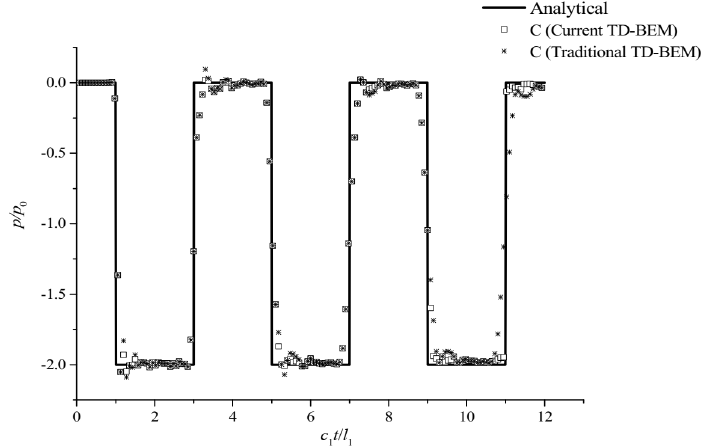
Figure 9. Comparison between the results of traction from current 3D TD-BEM, traditional 3D TD-BEM, and the analytical